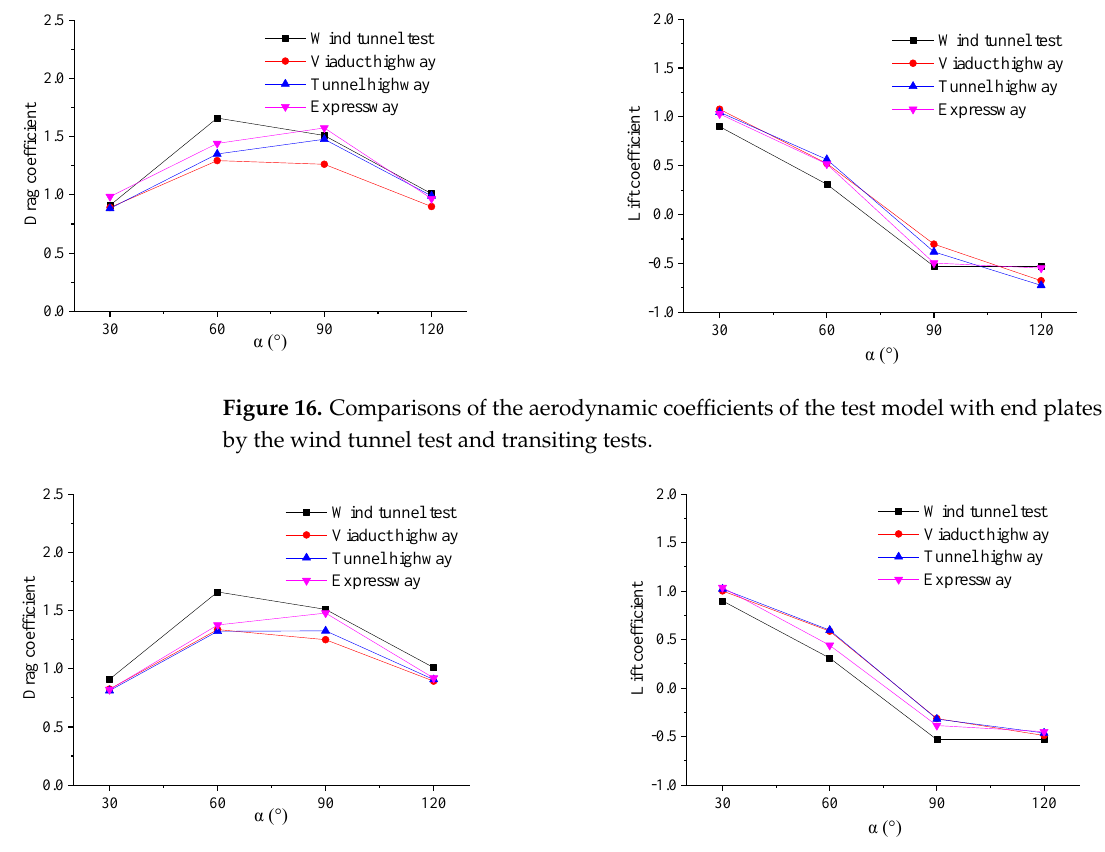
Figure 17. Comparisons of the aerodynamic coefficients of the test model without end plates mea- sured by the wind tunnel test and transiting tests.